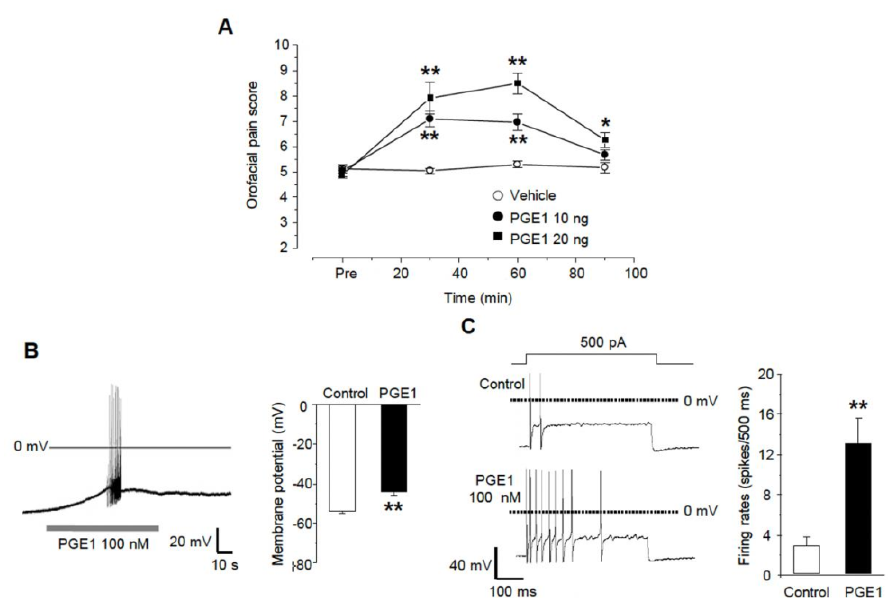
Figure 1. PGE1-induced mechanical allodynia and TG neuronal excitation. ( A ) Orofacial pain score was assessed by pain behavior (swipes and biting or withdrawal of head) during 90 min after the subcutaneous injection of vehicle or PGE1 (10 and 20 ng/10 µ L per site) into the whisker pad of mice (score at 30 and 60 min, n = 6, * p < 0.05, ** p < 0.001 compared to the vehicle group, one-way ANOVA). ( B ) The effects of PGE1 on firing patterns in TG neurons. The application of PGE1 (100 nM) induced the spontaneous bursting action potentials (left) and the depolarization of RMP (right) in current-clamp recording (n = 9, ** p < 0.001, paired t -test). ( C ) Left: representative traces after a 500 ms current injection (100~500 pA) before and during exposure to PGE1(100 nM) in current-clamp mode. Right: summary of action potential firing rates under each condition (n = 10, ** p < 0.001, paired t